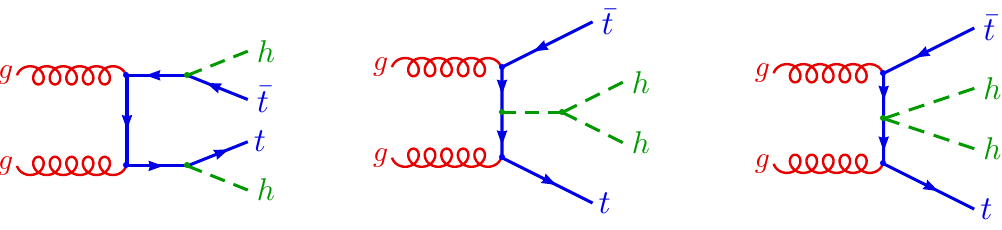
Figure 3 . Representative diagrams for the non-resonant tthh process, illustrating the three distinct physical subprocesses: the Yukawa vertex, the Higgs trilinear self-coupling and the “double Higgs” Yukawa vertex arising in composite Higgs